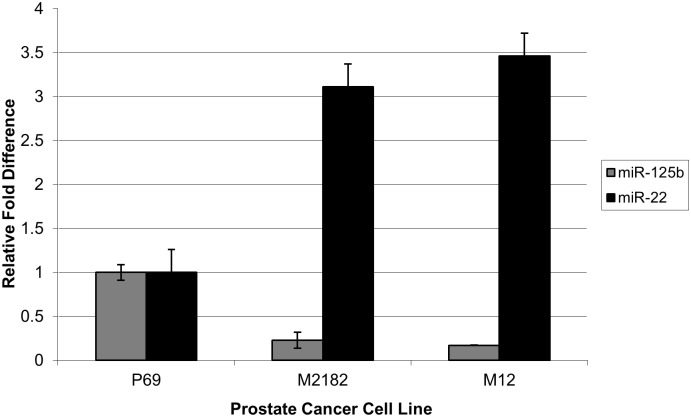
Dysregulation of miR-125b and miR-22 in the p69/M12 human prostate cancer cell line progression model.Comparison of miR-125b (grey) and miR-22 (black) levels in RNA extracted from p69, M2182 and M12 cell lines by SYBR based qRT-PCR as described in Materials and Methods. Fold difference was calculated as the mean of three independent experiments analyzed in triplicate and normalized to RNU48 (ΔCT) as an internal control and expressed relative to the parental p69 cell line using the comparative CT method [23]. ANOVA test indicates a significant difference with a P-value < 0.05.